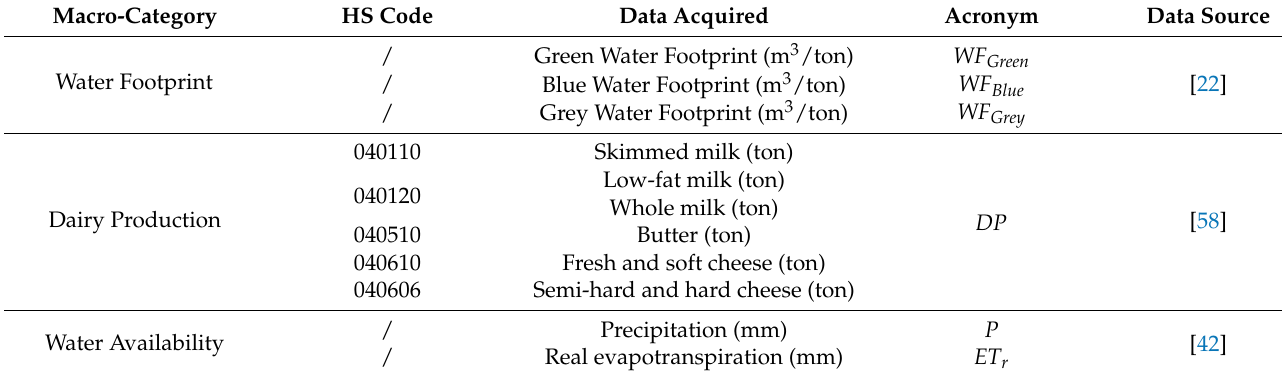
Table 1. Data source, classifications, and